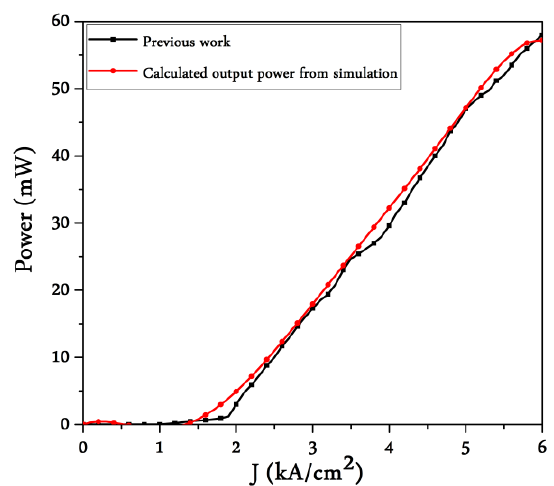
Figure 15. Comparison of output power vs. current curve for InGaN/GaN QW-based green laser (λ = 508 nm) calculated by our simulation model in polar (0001) orientation with the results reported in [45].